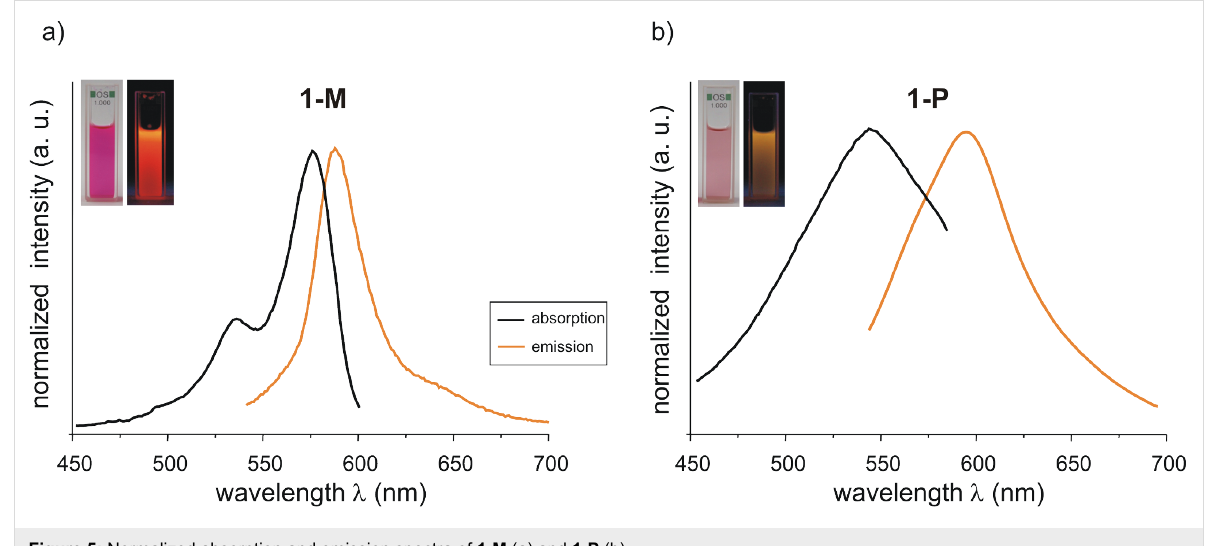
Figure 5: Normalized absorption and emission spectra of 1-M (a) and 1-P (b).